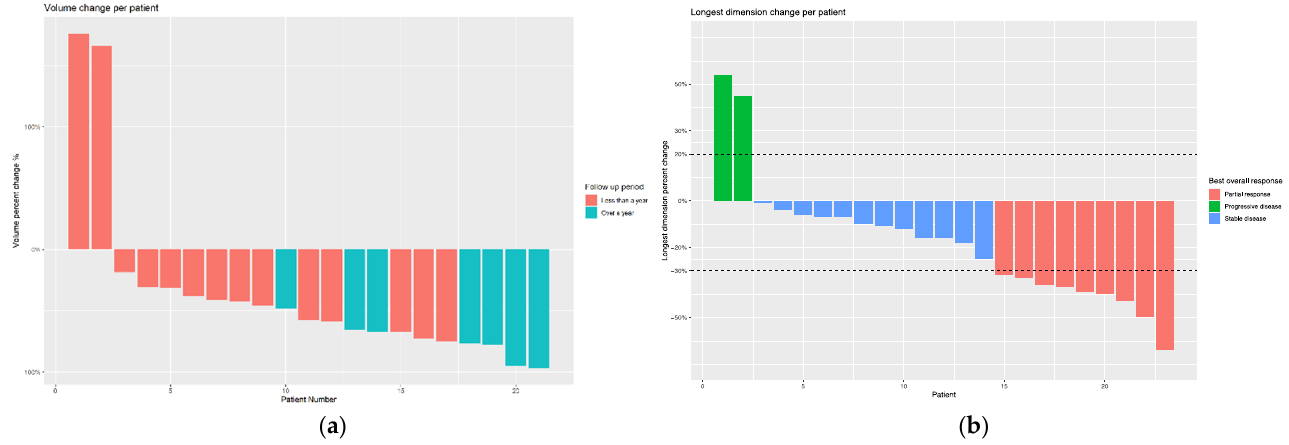
Figure 2. ( a ) Change in tumor volume per patient, where red and blue represent patients who were followed up for <12 months and ≥ 12 months, respectively; ( b ) change in the diameter of the tumor (longest dimension) per patient with corresponding RECIST 1.1 results (red, partial response; blue, stable disease; green, progressive disease).